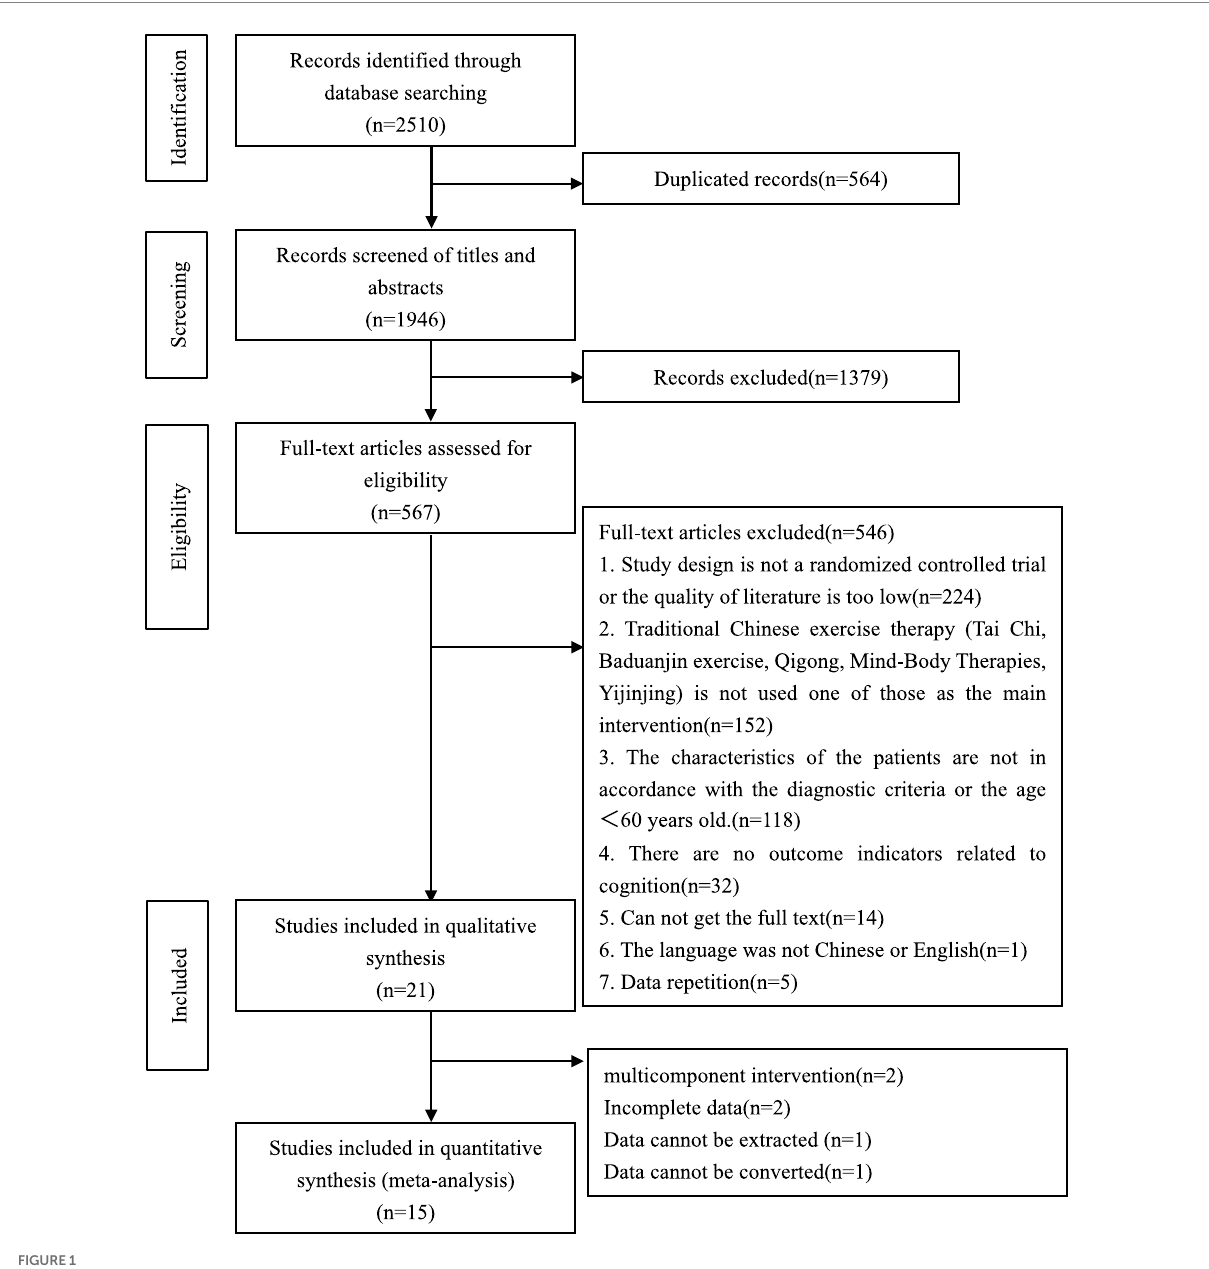
FIGURE 1 Flow chart of study